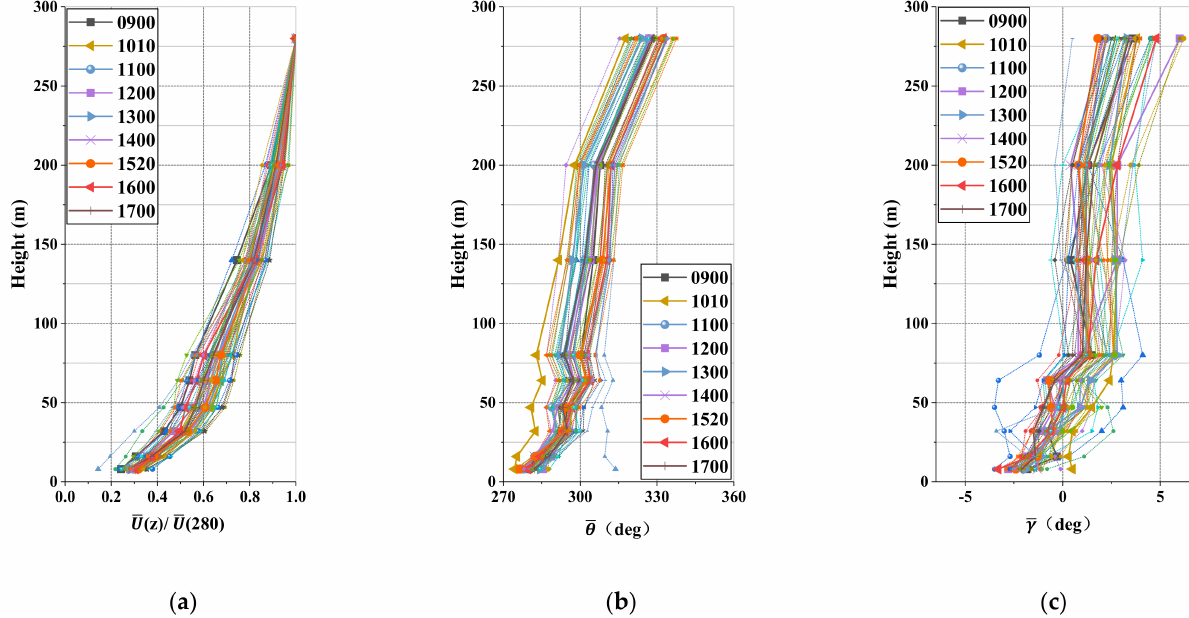
Figure 11. The profiles of 10-min mean wind speed normalized by the value at 280 m ( a ), the horizontal direction ( b ) and the wind angle of attack ( c ) related to the strong wind records of a synoptic event which occured on 10 October